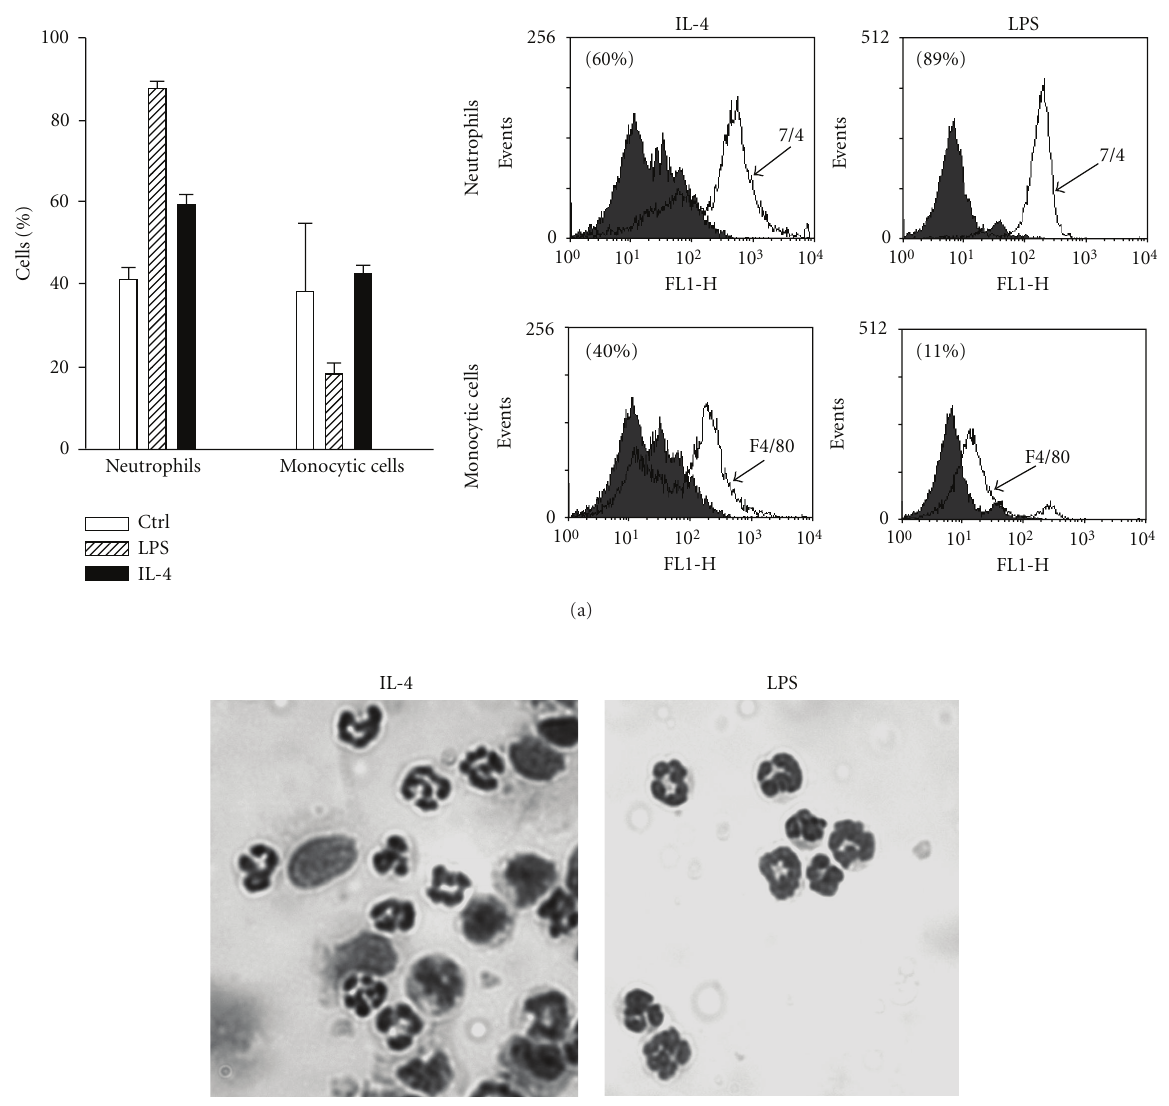
Figure 2: IL-4 induces the recruitment of neutrophil and monocytic cells in vivo. Murine air pouches were created and bu ff er, IL-4 (250ng/ml) or LPS (1 μ g/ml) was administered for 9 hours as described in Materials and Methods. (a) cell populations were identified by flow cytometry ( n ≥ 6) after staining with purified rat antimouse 7/4 mAb directed against murine neutrophils (neutro, open curve) or rat antimouse F4/80 Ag Ab recognizing murine monocyte/macrophages (mono, open curve) as described in Materials and Methods. Inset, representative data plotted in the bar graph, where the grey curves illustrate the appropriate isotypic controls. (b) cell identification was confirmed by cytology. Results are from one representative experiment out of at least